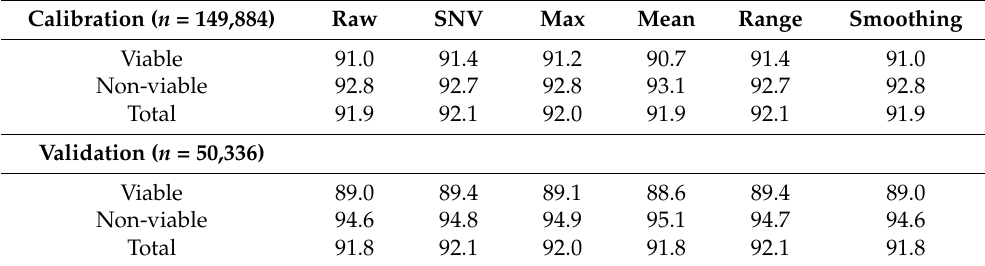
Table 2. Calibration and validation results based on pixels (unit: %) of PLS-DA model developed with different preprocessing methods using full